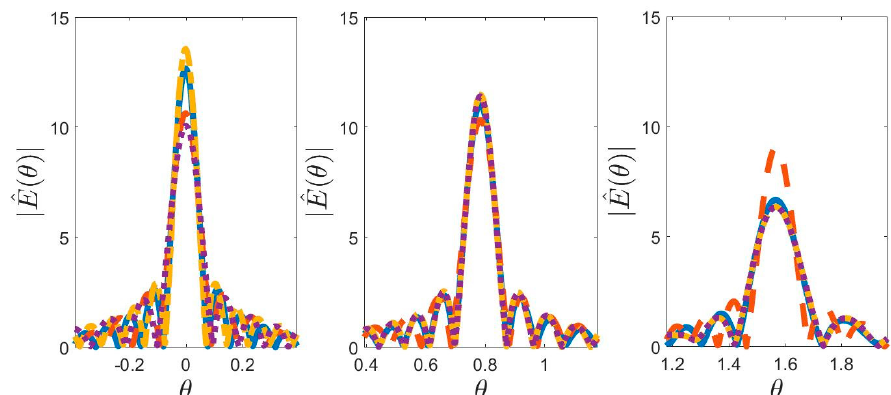
Figure 8. The amplitude of the field ˆ E ( θ ) radiated by the semi-circumference array (solid blue lines), the trapezoidal array (dash-dotted yellow lines), the sides 1–2 of the trapezoidal array (dot- ted violet line), and the angle array (dashed red lines) of Figure 4. The plots present the field am- plitudes for the choice L = 20 λ . From left to right, the three panels refer to the focusing angles θ 0 = 0, π /4, π /2,